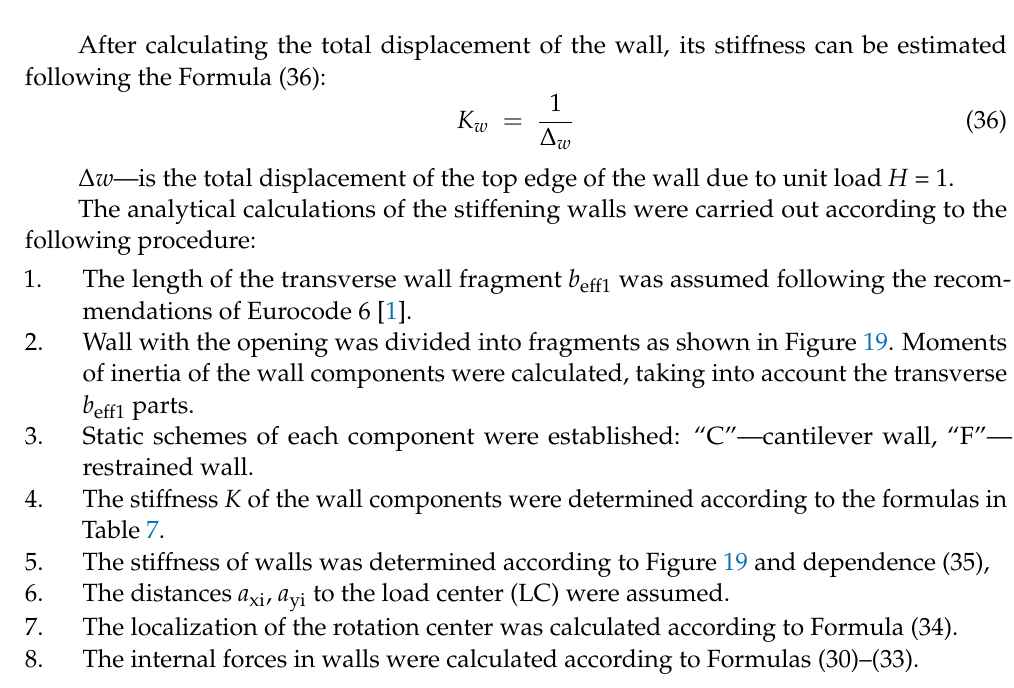
Figure 19. Total wall stiffness method [6]: ( a ) division of a wall with openings into component elements, ( b ) wall deformation caused by horizontal loads. The displacements of the wall components depend on the geometry and boundary conditions. If the height ratio to the wall’s length is h / l > 2, the effects of tangential stresses